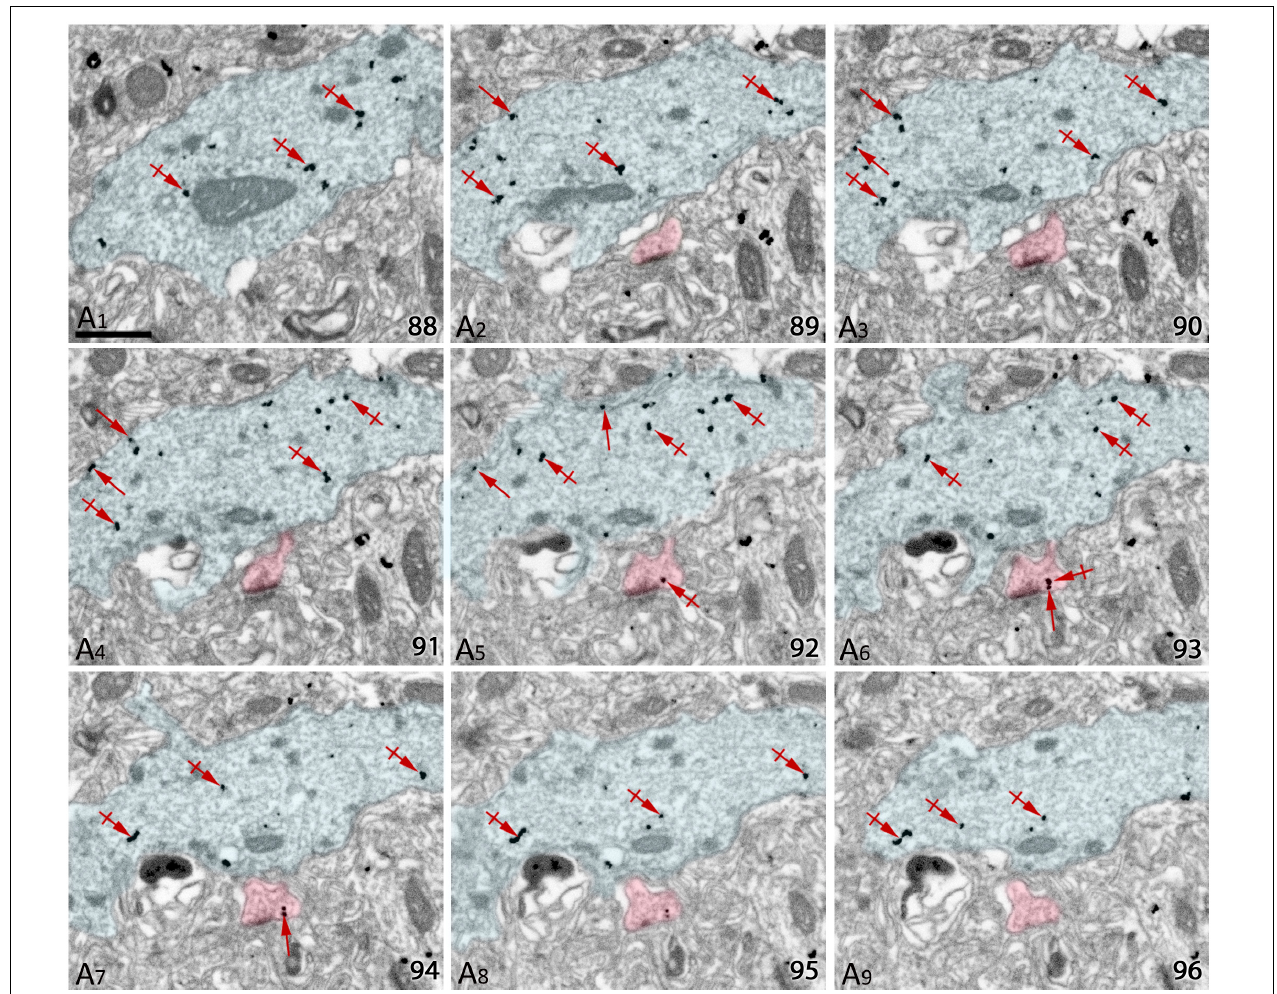
FIGURE 2 | Serial images obtained by FIB/SEM from the neuropil of hippocampal CA1. (A1–A9) Selected sections (88–96) from a FIB/SEM stack of images obtained from the stratum radiatum of the CA1 field illustrating dendritic shafts (pseudo colored in blue) and spines (pseudo colored in red) of pyramidal cells immunolabelled for SK2. Immunoparticles for SK2 can be visualized along the plasma membrane (arrows) and at cytoplasmic sites (crossed arrows). Scale bars: (A) 1 µ